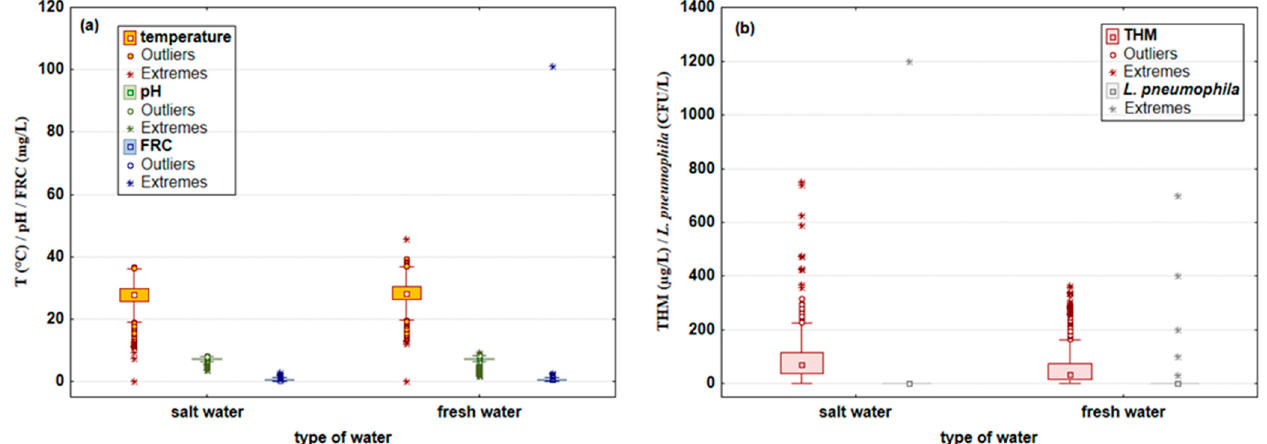
Figure 3. Water physicochemical parameters: ( a ) temperature (°C), pH, and free residual chlorine (FRC; mg/L), and ( b ) trihalomethanes (THM; μ g/L) and amount of Legionella pneumophila (CFU/L) in swimming pools with fresh and salt water. Results are shown as median, minimum, and maximum values with outliers and extreme values (N pool data = 4587; N saltwater data = 1478; N freshwater data =